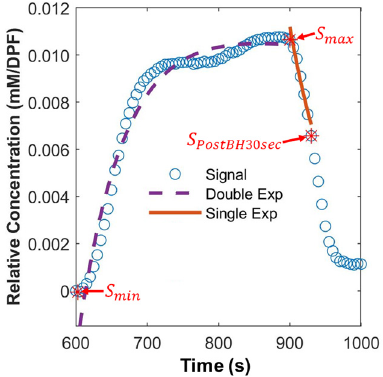
Figure 2. Example of hemodynamic features extraction (from the grand average of ∆ RHb of the AD group). Blue dots indicate the signal. S min : the smallest amplitude of the signal between 600 and 700 s; S max : the largest amplitude of the signal between 900 and 1000 s; S PostBH 30 sec : the amplitude at 930 s (30 s after the end of hypoxic respiratory challenge). A purple dashed line indicates the result of the double exponential fitting to the signal between 600 and 900 s. An orange line indicates the result of the single Exponential fitting to the signal between 900 and 930 s.